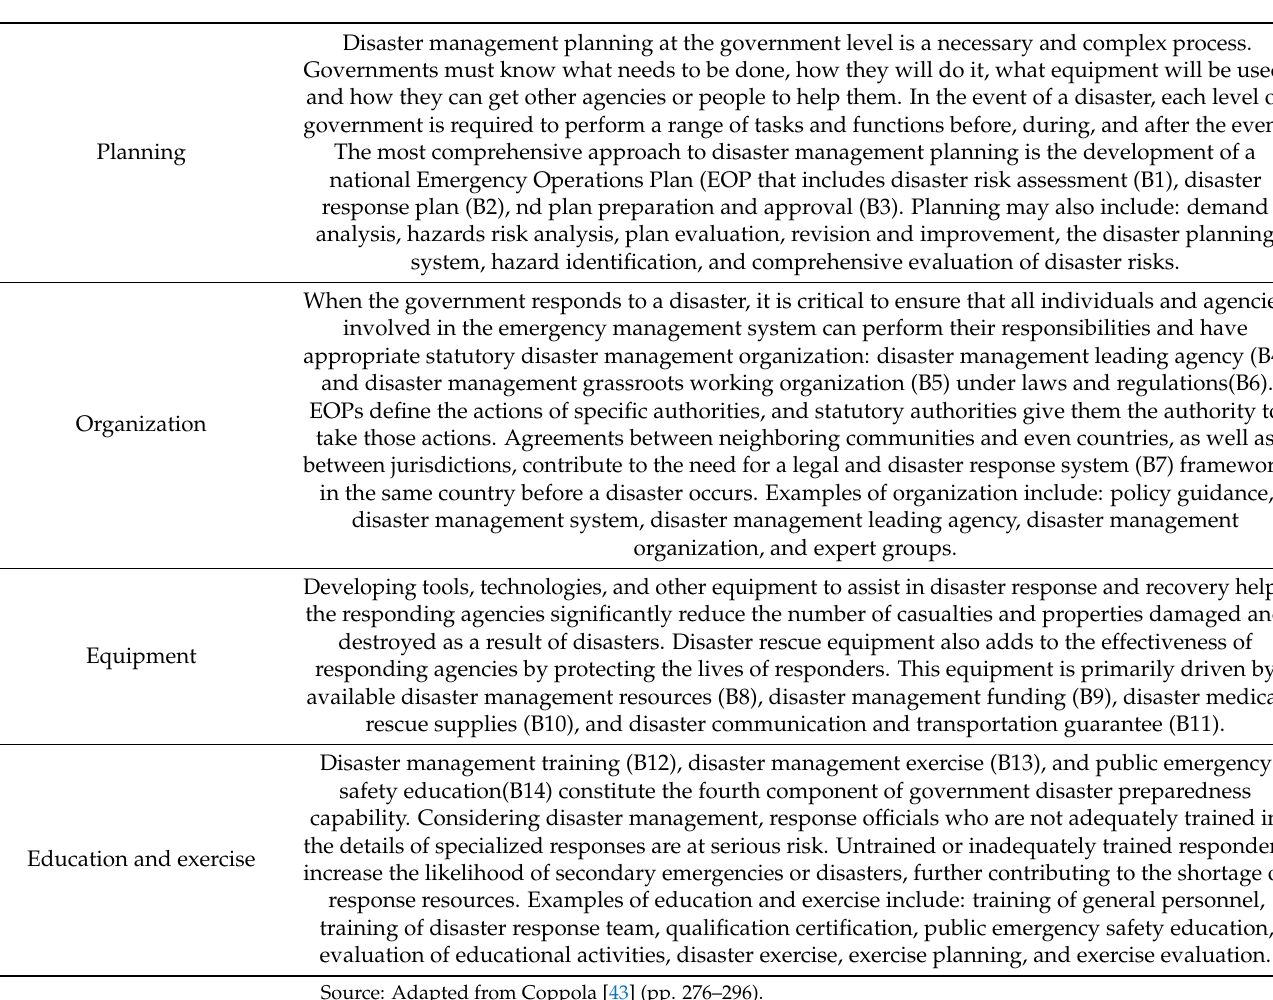
Table 1. Components of disaster preparedness